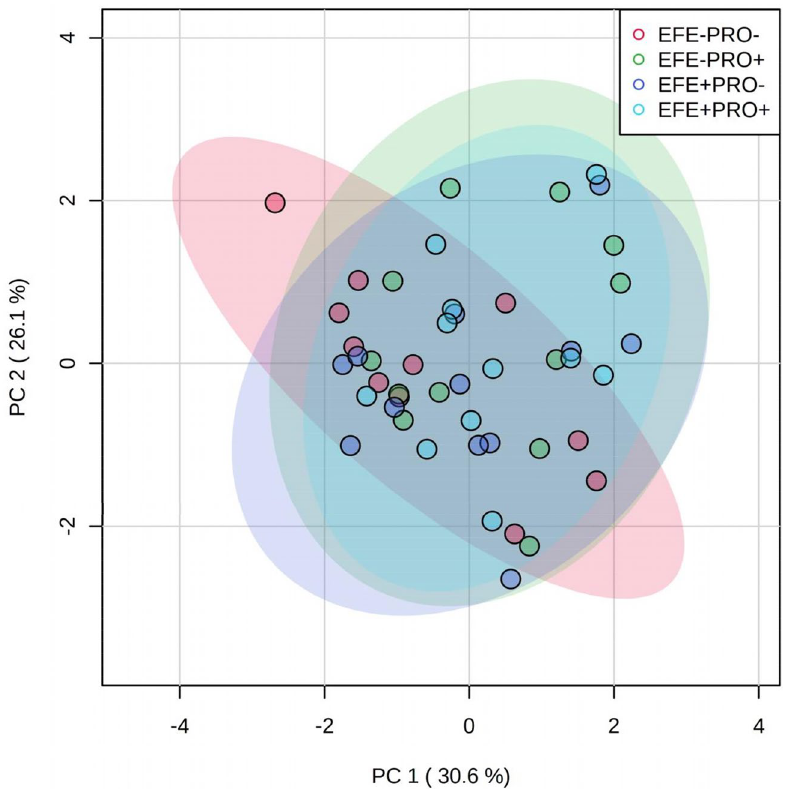
Figure 4. Principal component analysis (PCA) shows the interaction of the different experimental diets (colored) for all log-transformed and Pareto-scaled data for growth performance, health, and behavior. Treatments were (1) calves fed diets without exogenous fibrolytic enzymes (EFE)-treated wheat straw and probiotic supplement (EFE-Pro−), (2) calves fed diets of EFE-treated wheat straw but with probiotic supplement (2 g/d/calf; EFE-Pro+), (3) calves fed EFE-treated wheat straw (2 g/d/calf) but without probiotic supplement (EFE+ Pro−), (4) calves fed EFE-treated wheat straw and probiotic supplement (EFE+ Pro+). Exogenous fibrolytic enzymes were applied to wheat